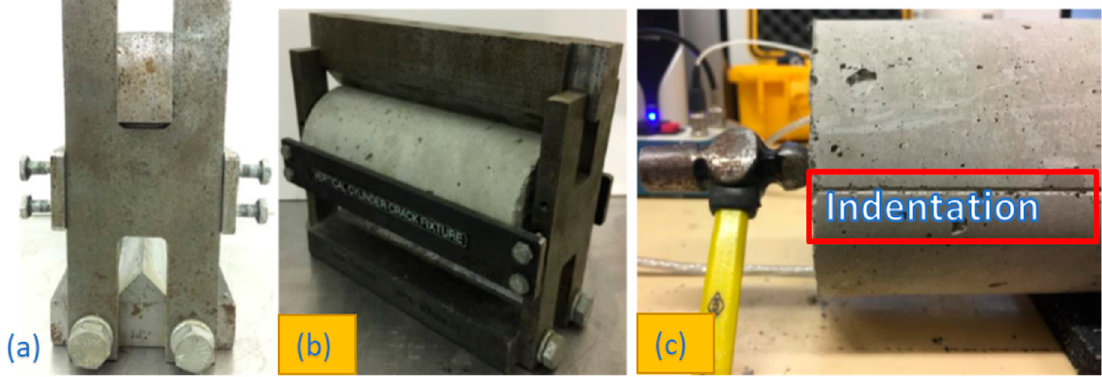
Figure 4. Setup for cracking ( a ) Standard Crack Inducing Jig (SCIJ) Front view ( b ) cylinder held in SCIJ Isometric view ( c ) Longitudinal Impulse Direction Setup.